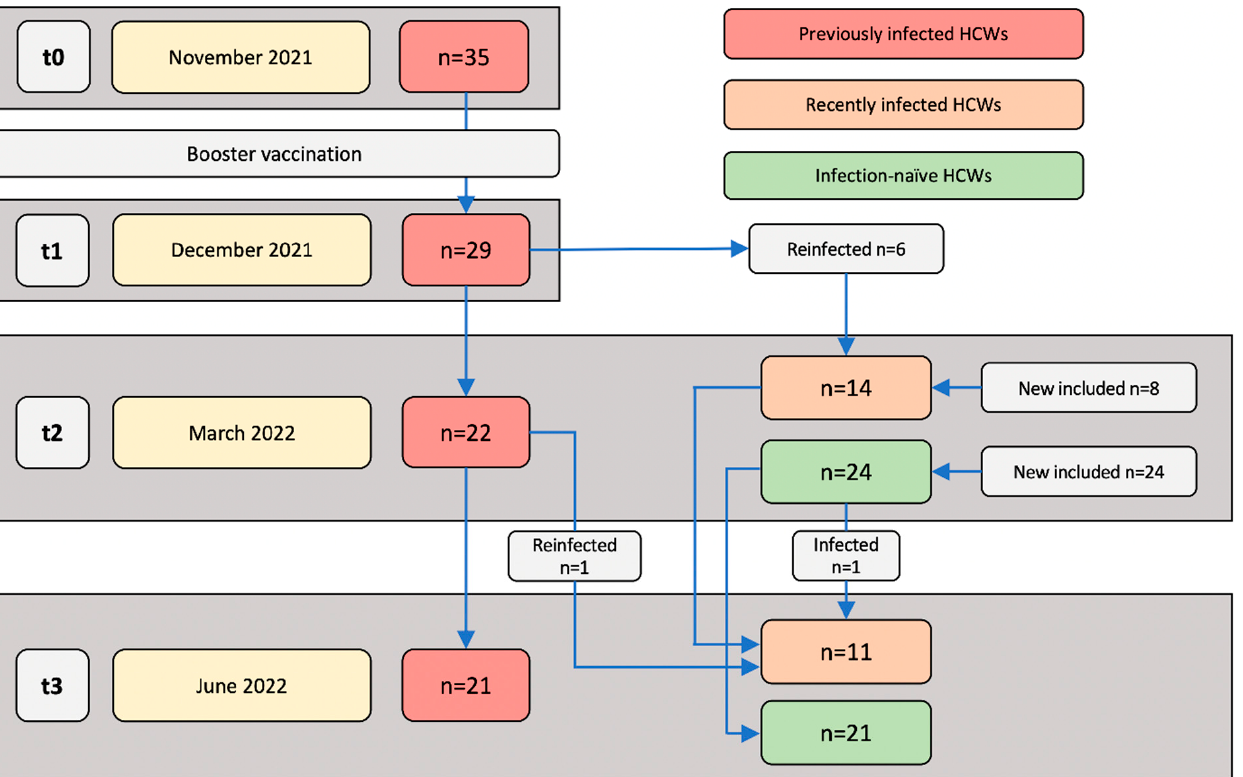
Figure 1. Study populations and sampling time points. Blood samples were collected and immune responses were assessed at the following four time points: November 2021 (t0; approximately two weeks before receiving a booster vaccination), December 2021 (t1; one month post ‐ booster vaccination), March 2022 (t2; four months post ‐ booster vaccination), and June 2022 (t3; seven months post ‐ booster vaccination).